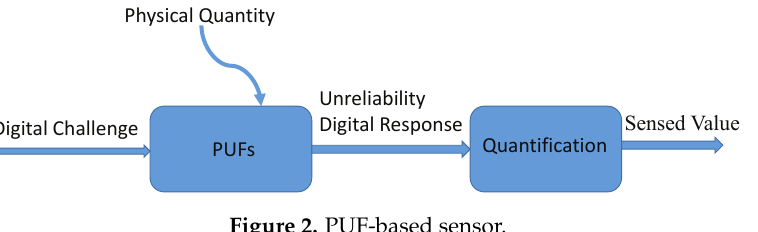
Figure 2. PUF-based